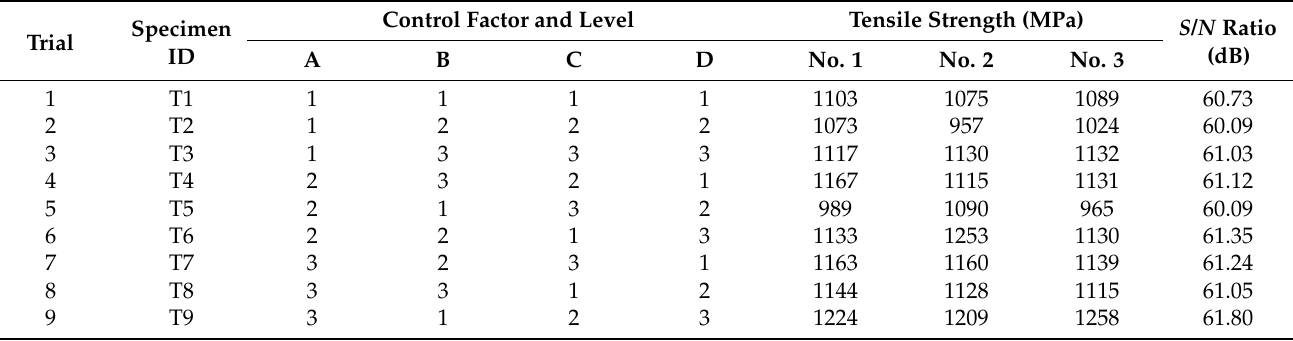
Table 4. Orthogonal array L9 (3 4 ) of experimental data and S / N